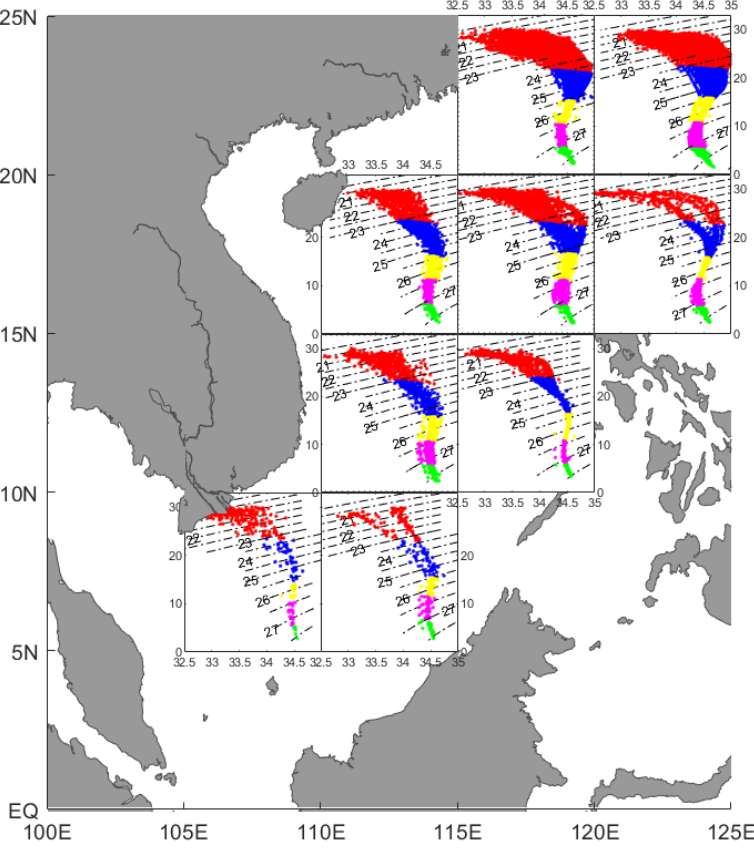
Figure 7. The same as Figure 5 but in summer.